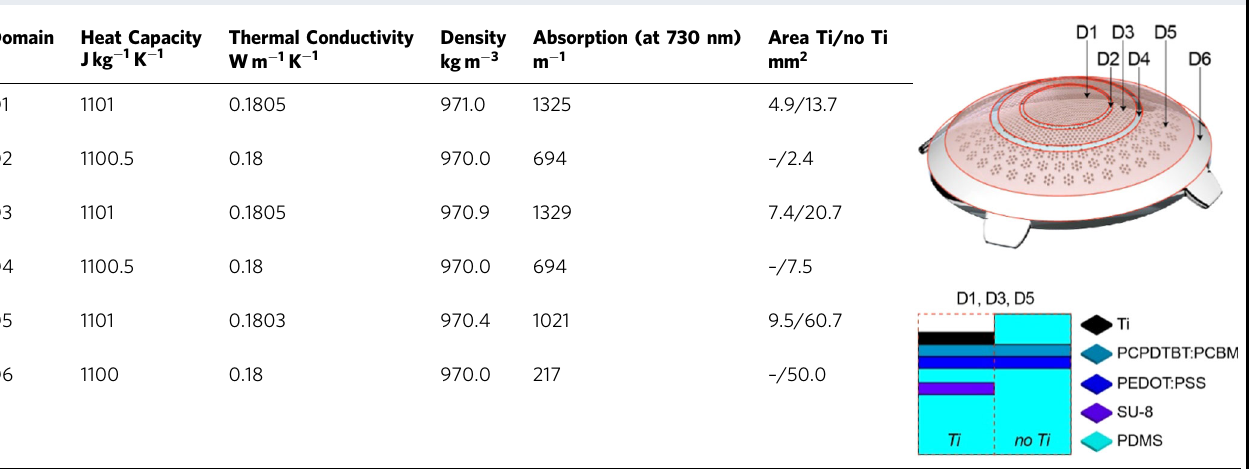
Table 2 Aggregated parameters for nirPOLYRETINA.